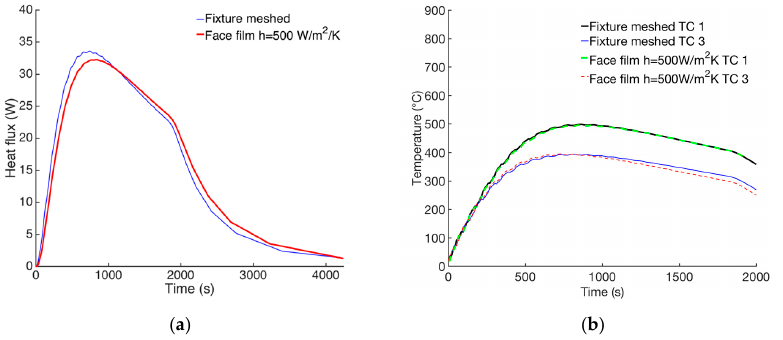
Figure 6. Comparison of the total heat loss from baseplate to fixture ( a ) and the temperature in positions TC 1 and TC 3 ( b ) for the model with meshed fixture and the model with the fixture replaced by a convective boundary condition.